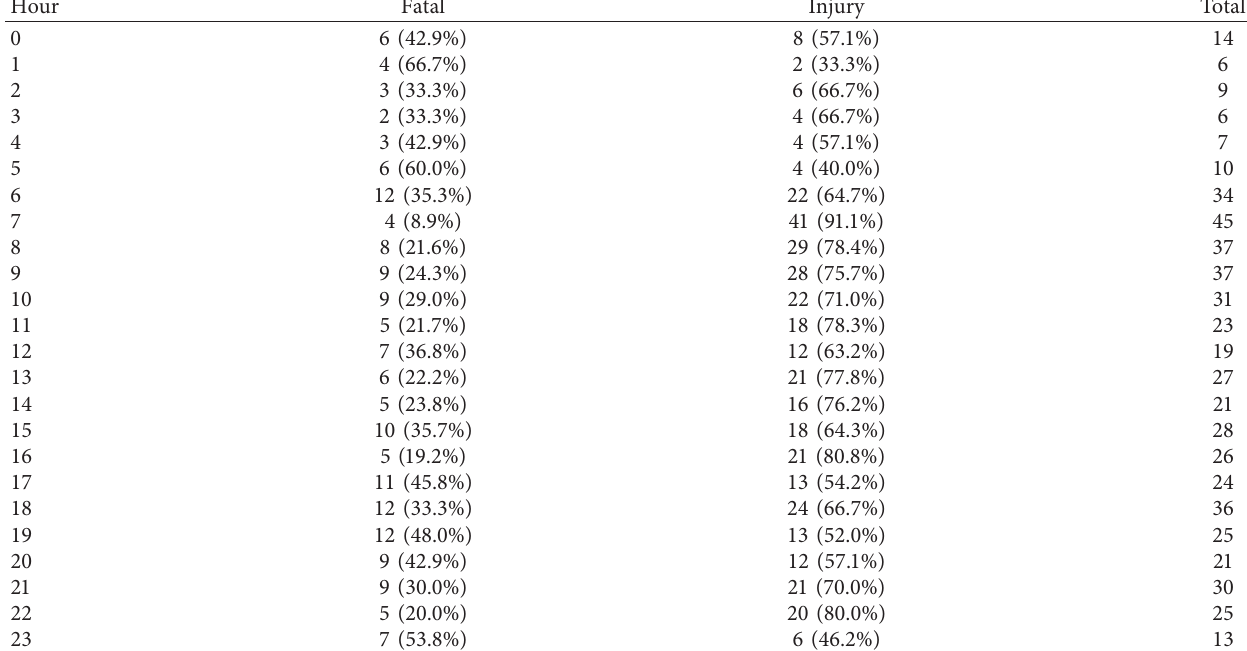
Table 4: Statistical information of hours of the day for injury